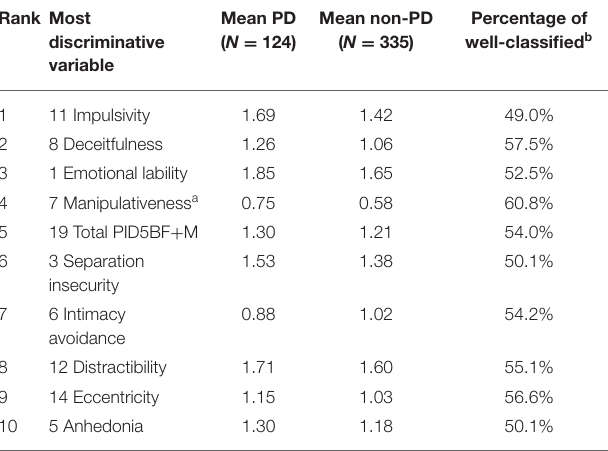
M facets and total in the +